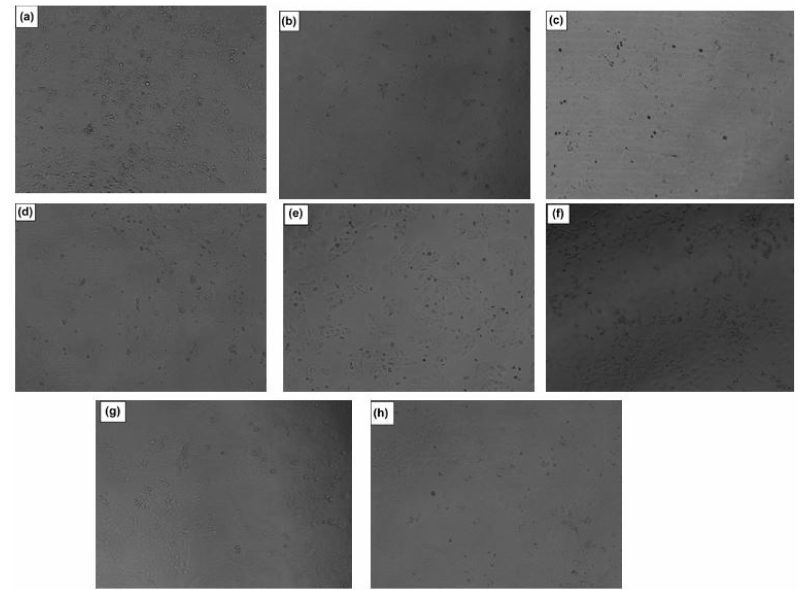
Figure 14. Light-microscopy images of the ( a ) plain hydrogel, ( b ) HCT-loaded hydrogel, ( c ) pure HCT, ( d ) HCT-loaded nanoparticles, ( e ) blank nanoparticles, ( f ) 5-FU, ( g ) untreated cells, and ( h ) DMSO control after 48 h treatment. The scale bar is 100 µ